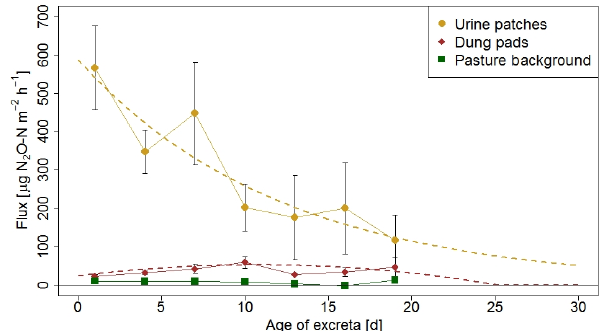
Figure 8. N 2 O flux evolution with time for urine patches, dung pats, and background areas. The fluxes were measured with the fast box and averaged over 3-day periods, and the error bars show the stan- dard error of the measurements. The standard errors for the back- ground fluxes are smaller than the symbols. The dotted lines show the fitted curves through the averaged values of urine and dung patch emissions (see also Eqs. 3 and